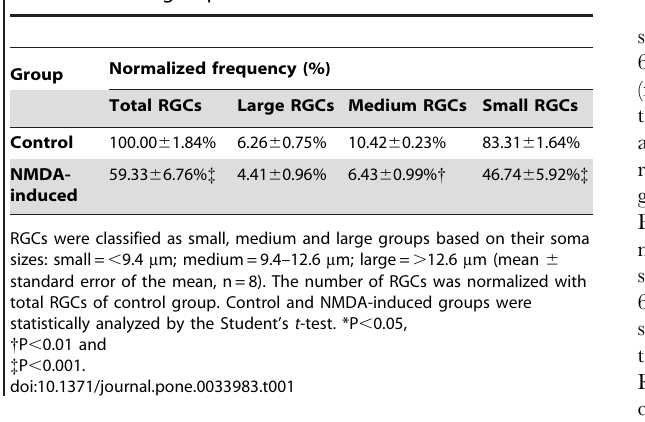
Table 1. Normalized frequency of rat RGCs in control and NMDA-induced